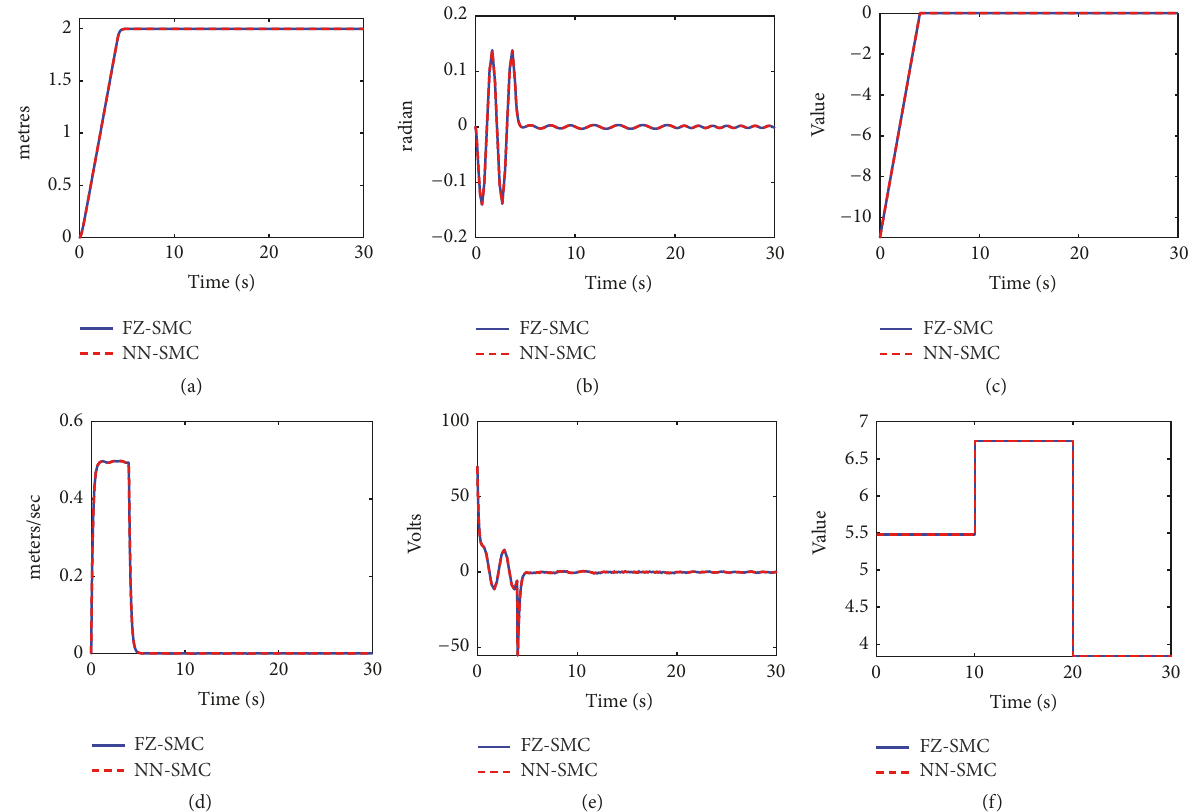
Figure 8: Responses of the FZ-SMC and NN-SMC controllers; (a) cart position, (b) payload sway, (c) sliding manifold, (d) cart velocity, (e) control effort, and (f) manifold